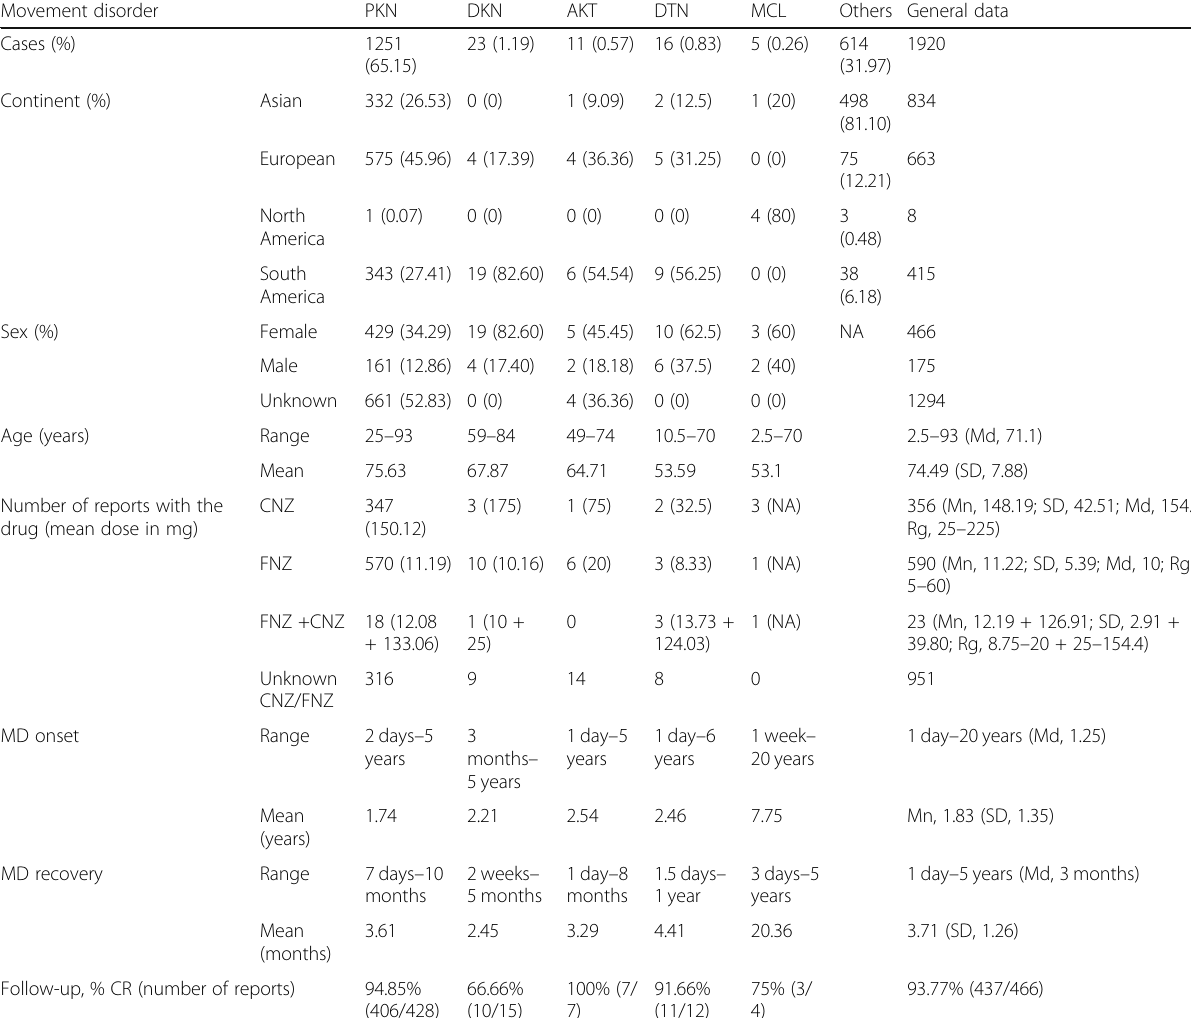
Table 2 Resume of CNZ/FNZ-associated movement disorders Movement